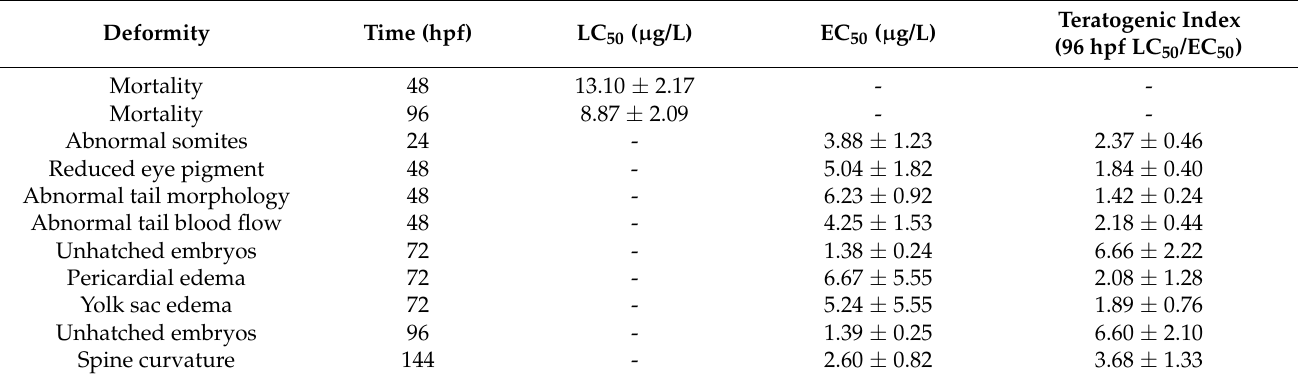
Table 2. Median lethal concentration (LC 50 ), median effective concentration (EC 50 ), and teratogenic index (TI) values obtained after thiram treatment.